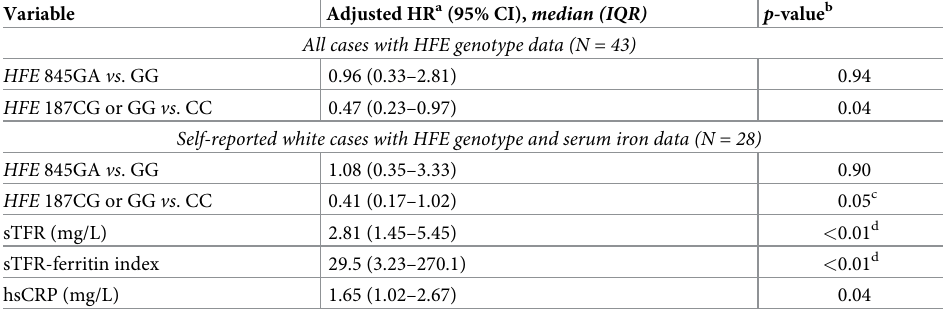
Among all neuropathy cases, HFE 187CG or GG genotype was associated with a significantly longer time to neuropathy onset than the ancestral CC genotype. Higher levels of the inflammatory biomarker hsCRP